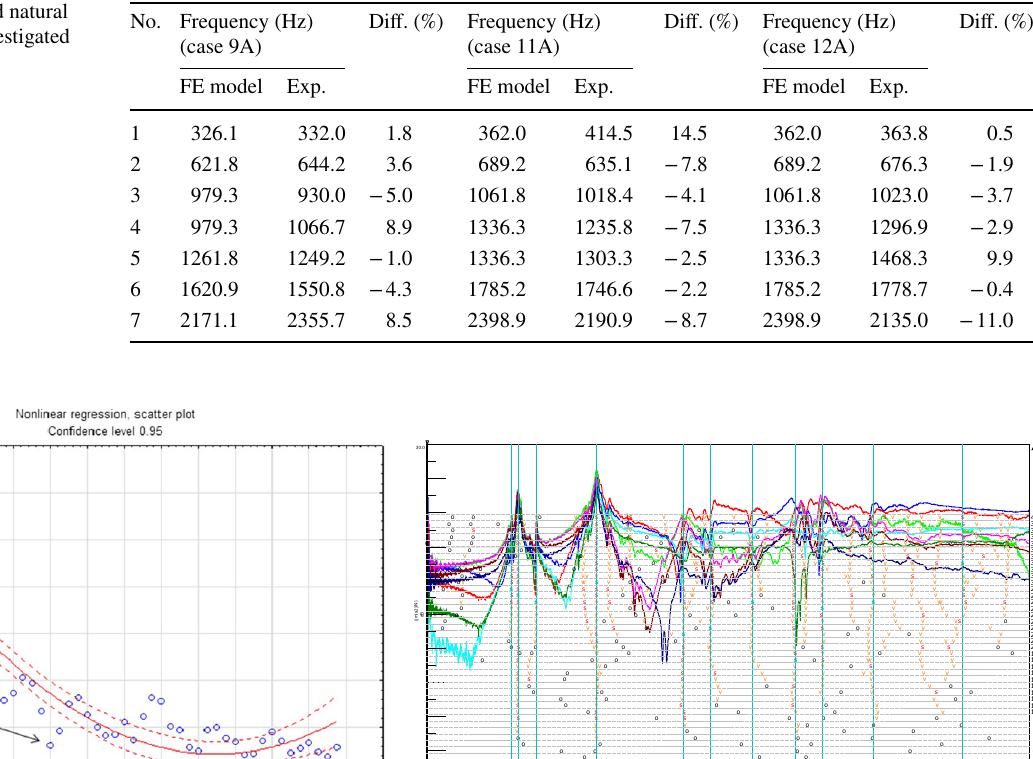
No. Frequency (Hz) (case 9A)